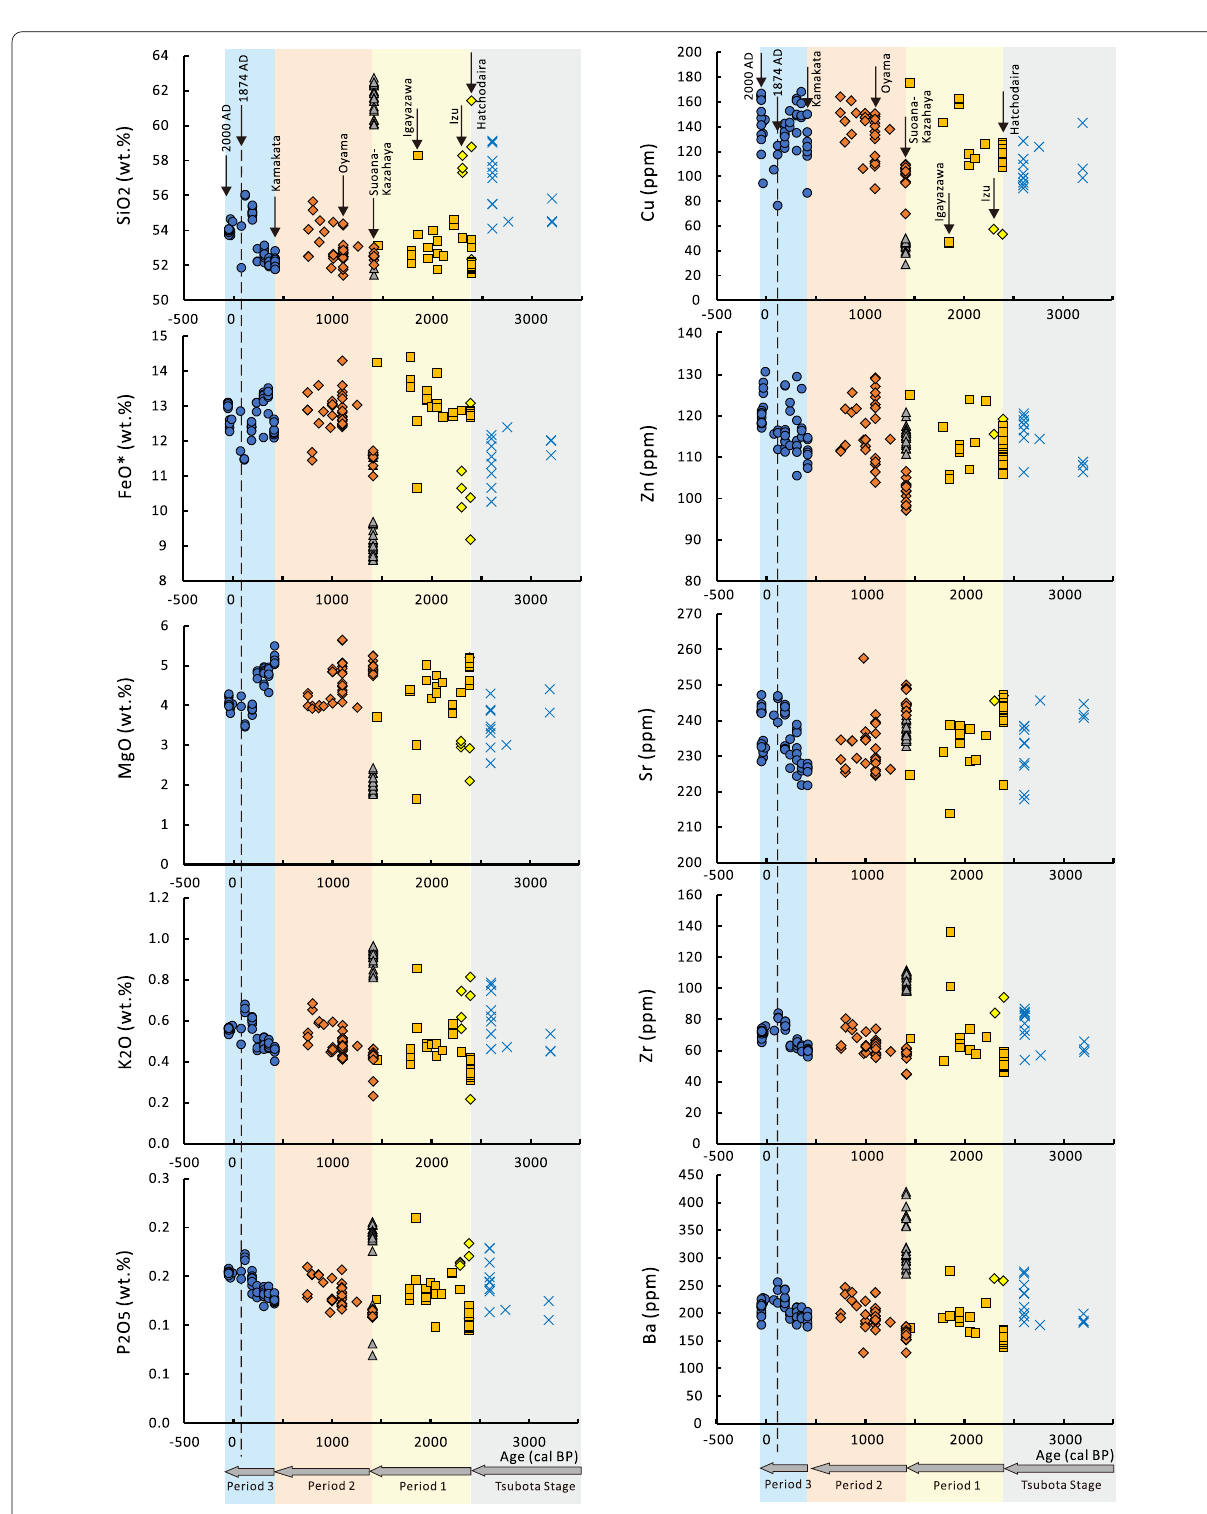
Fig. 10 (See legend on previous